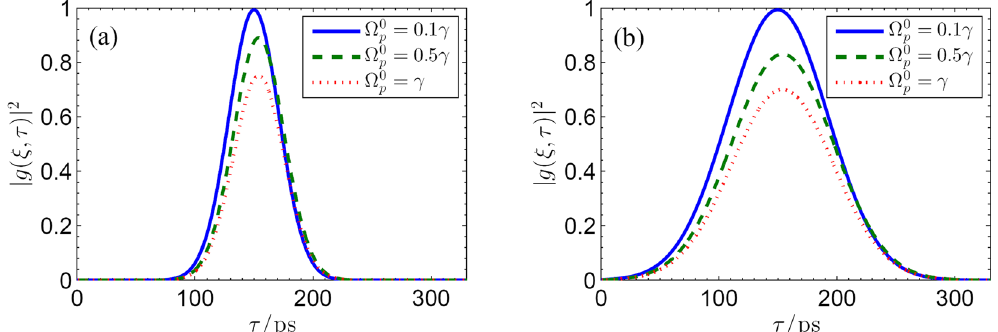
Figure 8. Snapshots of the temporal evolution of the switch THz pulse output terminal ( ξ ~ Δ z ) for different